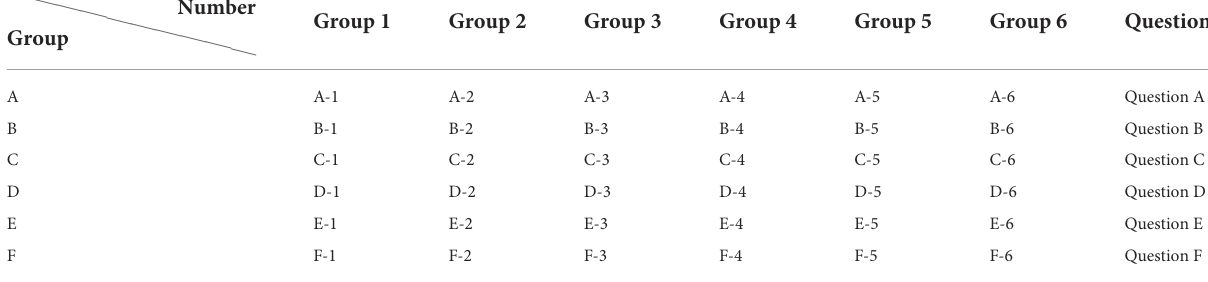
TABLE 2 New subgroups for cross-study in the experimental